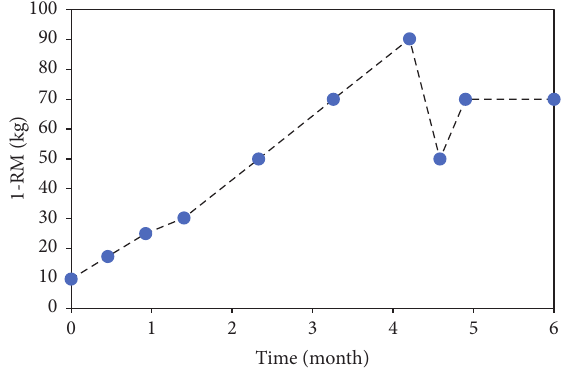
Figure 3: The weight lifted over the course of training. Following the two-week interruption of training, the weight was set to 50kg (time = 4.75 months) and to 70 kg during the last month